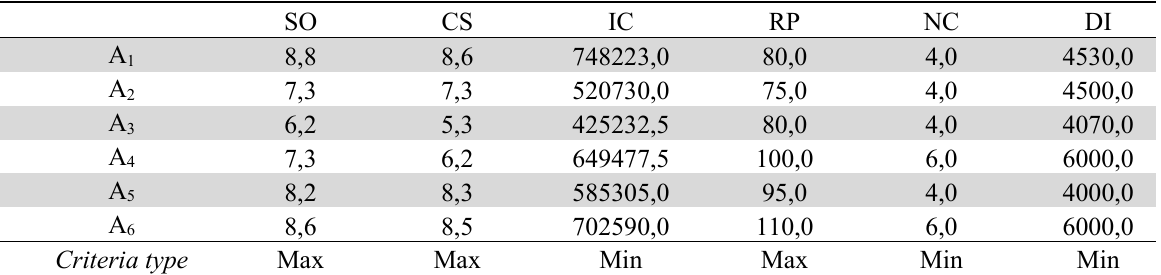
Decision matrix